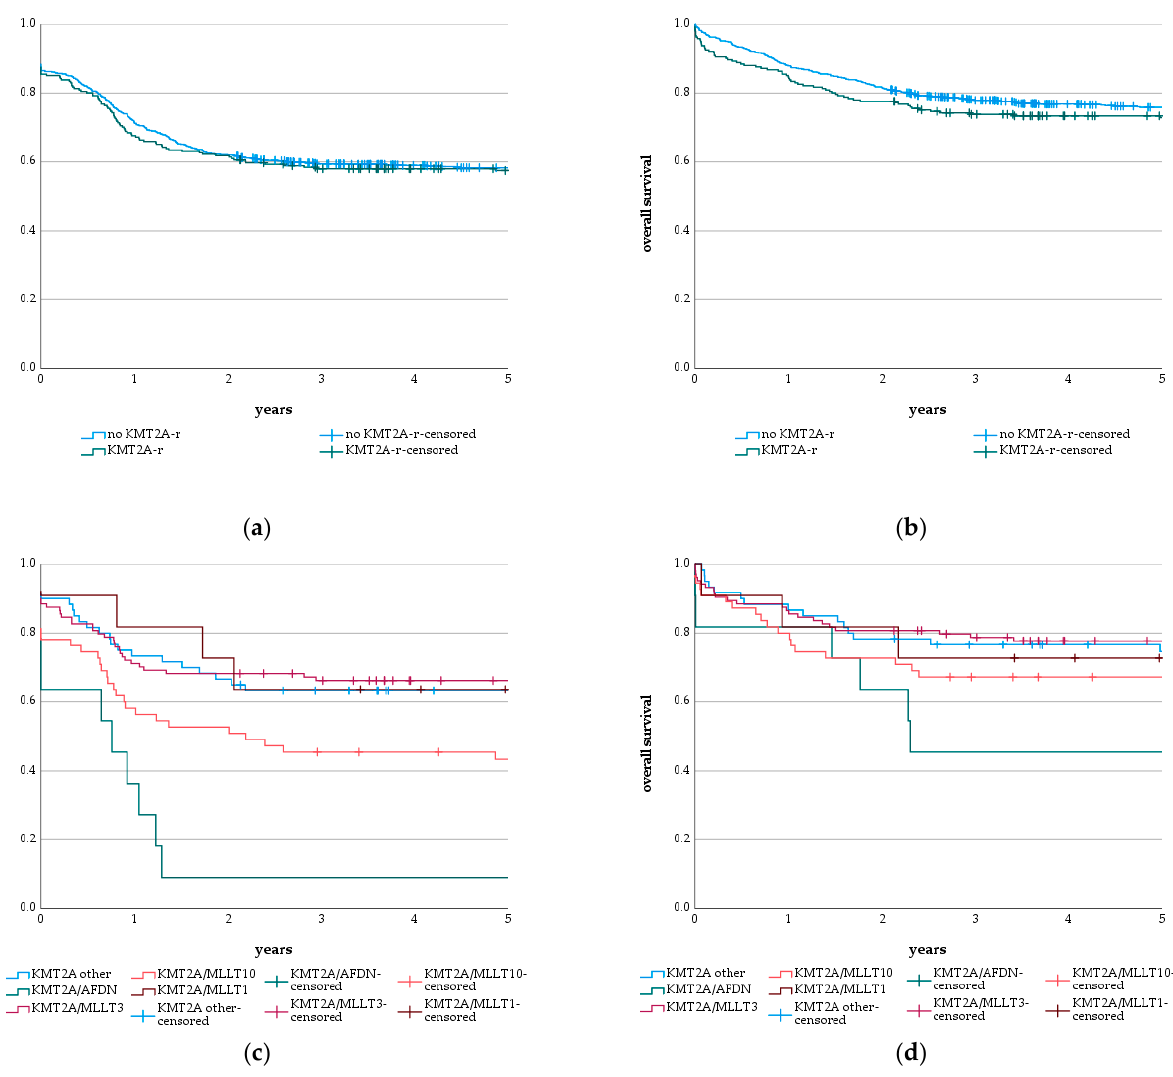
Figure 2. Survival of pediatric AML patients depending on KMT2A rearrangements ( KMT2A -r) and subgroups. ( a ) 5-year event-free survival (EFS) of pediatric AML patients with KMT2A -r (57.5% ± 3.2%) and without KMT2A -r (58.3% ± 1.8%) ( p = 0.640); ( b ) 5-year overall survival (OS) of pediatric AML patients with KMT2A -r (72.8% ± 2.9%) and without KMT2A -r (75.8% ± 1.6%) ( p = 0.298); ( c ) 5-year event-free survival (EFS) of pediatric AML patients with the translocations KMT2A/AFDN (9.1% ± 8.7%), KMT2A/MLLT1 (63.6% ± 14.5%), KMT2A/MLLT3 (66.3% ± 4.6%), KMT2A/MLLT10 (43.4% ± 6.7%) or other KMT2A -r (63.3% ± 6.2%) ( p < 0.001); ( d ) 5-year overall survival (OS) of pediatric AML patients with the translocations KMT2A/AFDN (45.5% ± 15.0%), KMT2A/MLLT1 (72.7% ± 13.4%), KMT2A/MLLT3 (77.7% ± 4.1%), KMT2A/MLLT10 (67.3% ± 6.3%) or other KMT2A -r (74.6% ± 5.7%) ( p = 0.176). Significance was calculated with log-rank test.